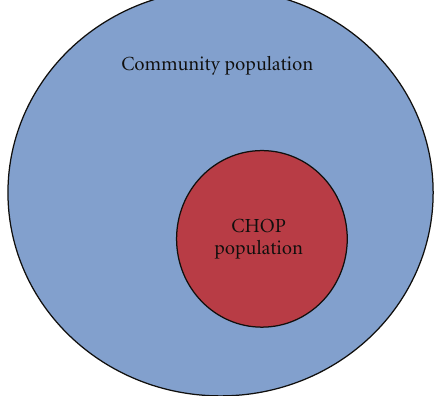
Figure 1: Conceptual framework for the study population.